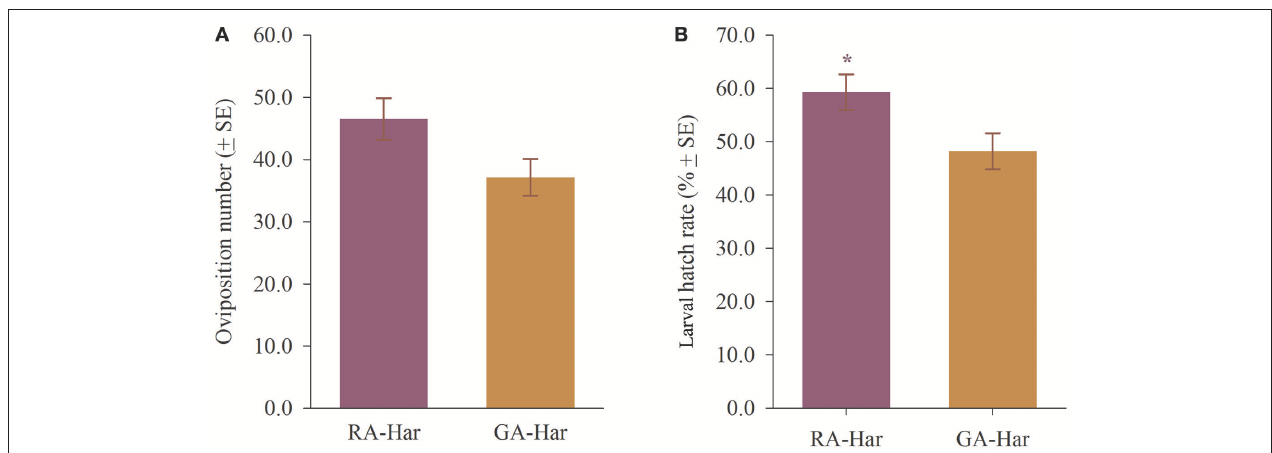
FIGURE 3 | Reproduction of H. axyridis on red and green morphs of A. pisum . The two lady beetle colonies were named as RA-Har and GA-Har, respectively. (A) Average number of eggs laid by a female, (B) larval hatch rate. Asterisk indicates a significant difference between RA-Har and GA-Har ( p < 0.05).